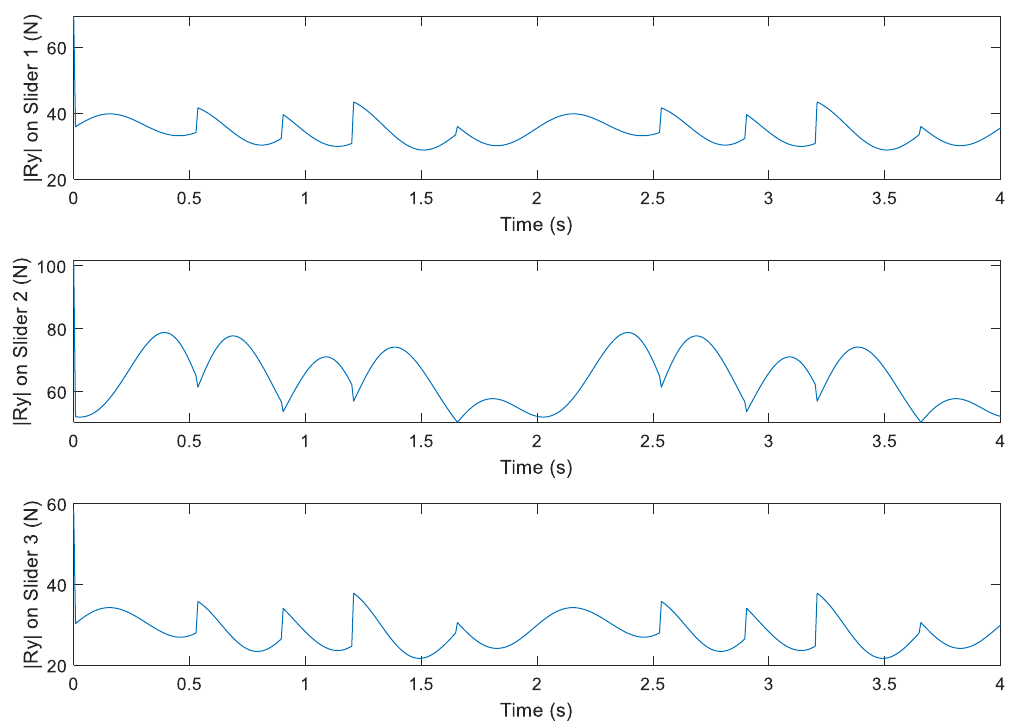
Figure 12. Comparison between the estimated and measured input forces: ( a ) using the Coulomb- viscous friction model and ( b ) using the Stribeck friction model.